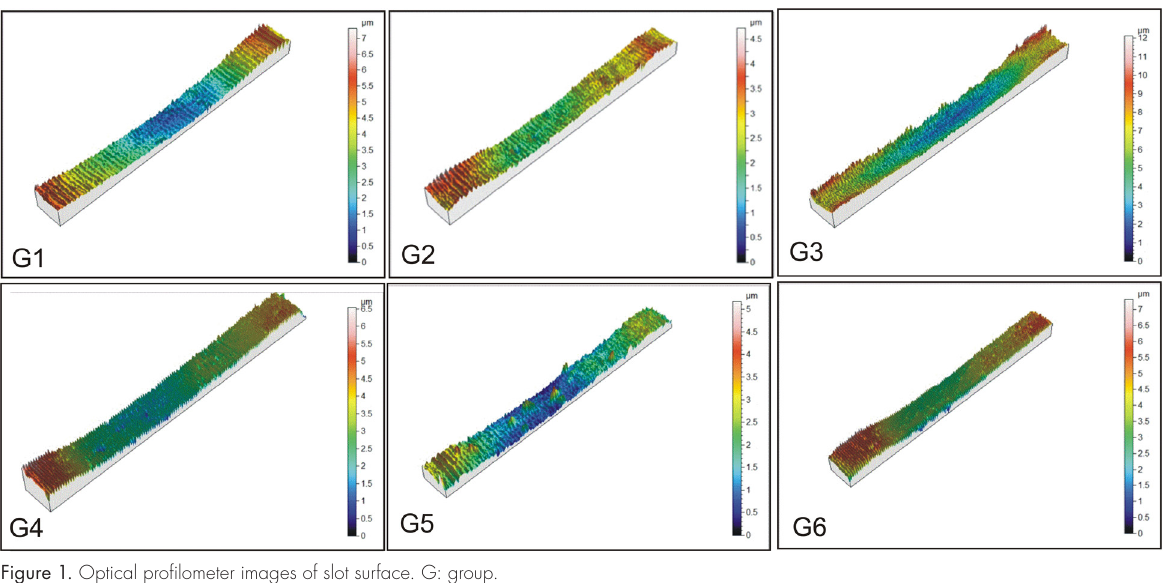
Figure 1. Optical profilometer images of slot surface. G: group.